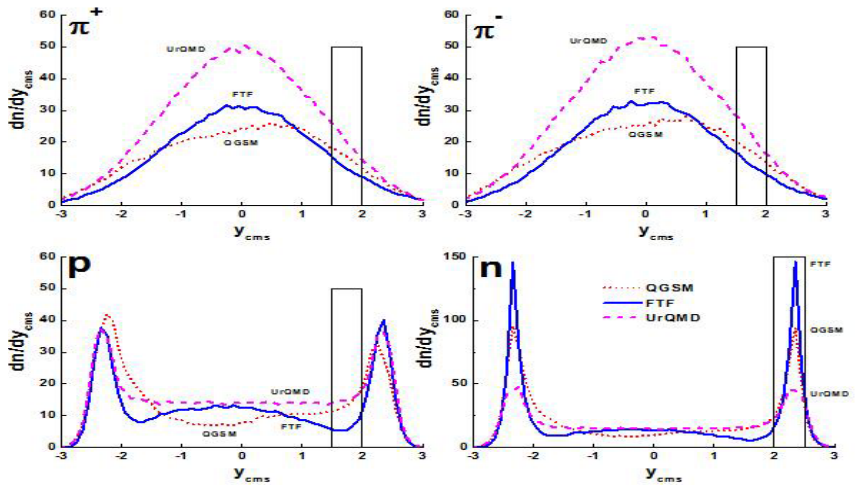
√ s = 10 GeV. Solid, dashed and dotted NN